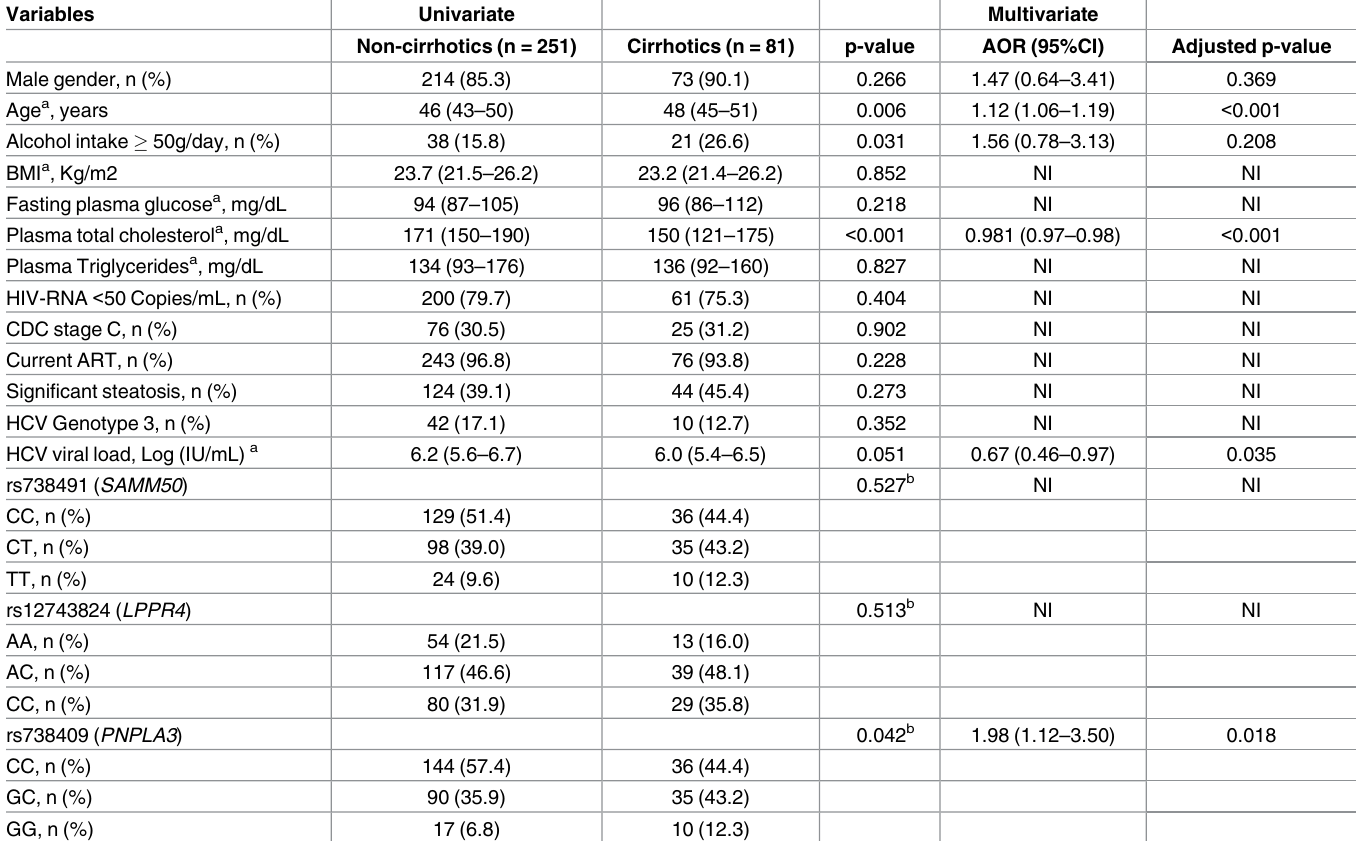
Table 2. Univariate and multivariate analysis of factors associated with cirrhosis (Study 1). Variables